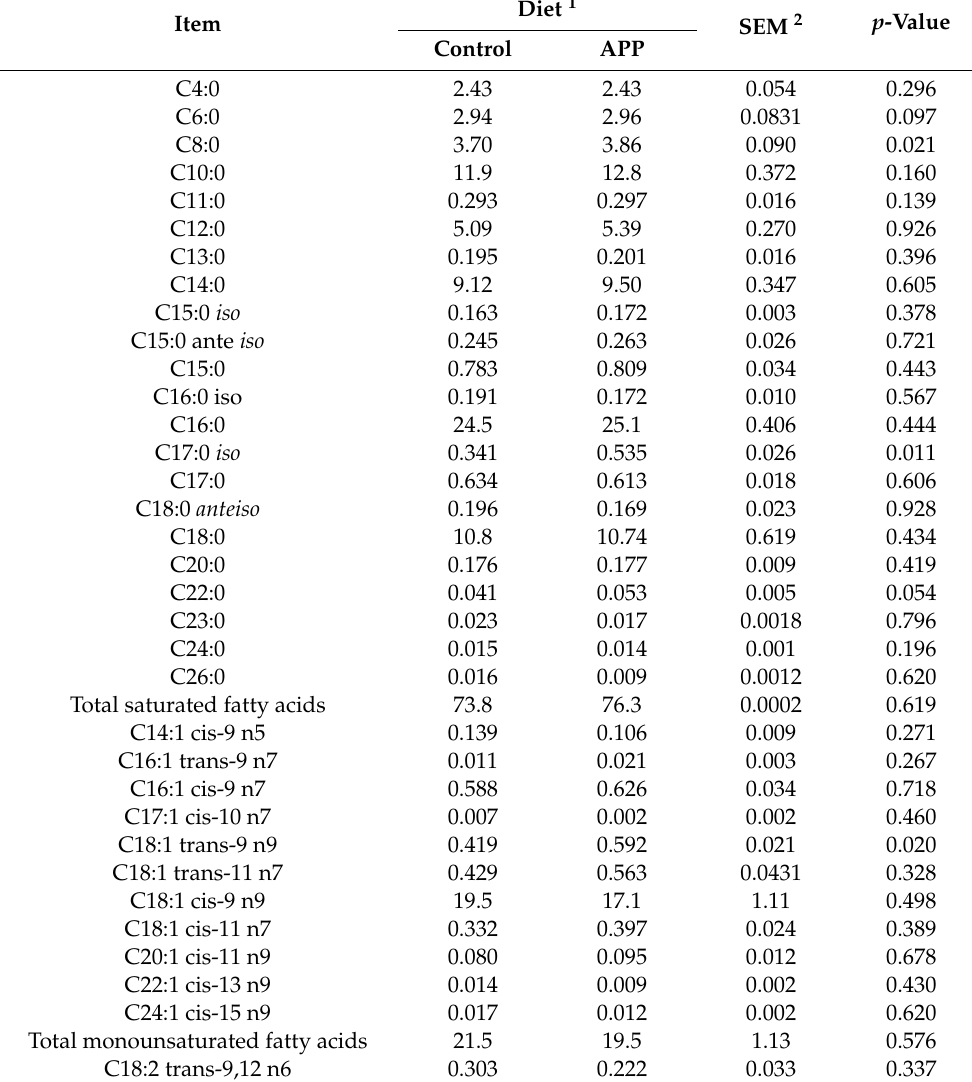
Table 5. Fatty acid (FA) profile (g / 100 g of identified FA) of milk fat from dairy goats fed the experimental